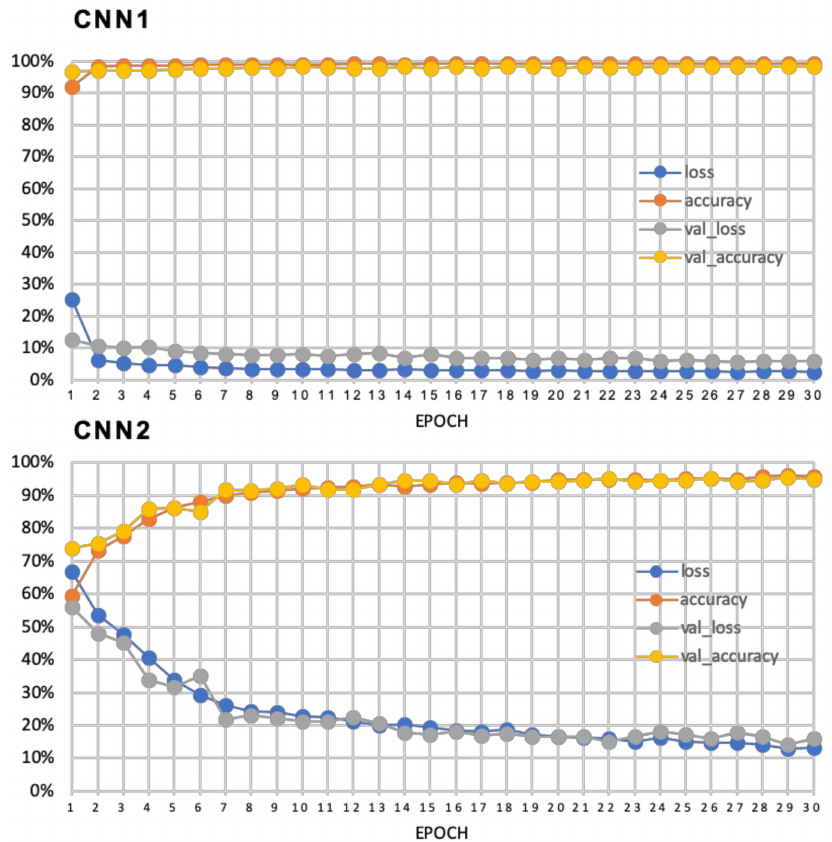
Figure 5. Training of the two CNNs for background vs. leaf disc (CNN1) and sporangiophores vs. no sporangiophores (CNN2). Training/validation accuracy and loss (binary cross entropy) are plotted for 30 epochs (loss = training loss, val_loss = validation loss, accuracy = training accuracy, val_accuracy = validation